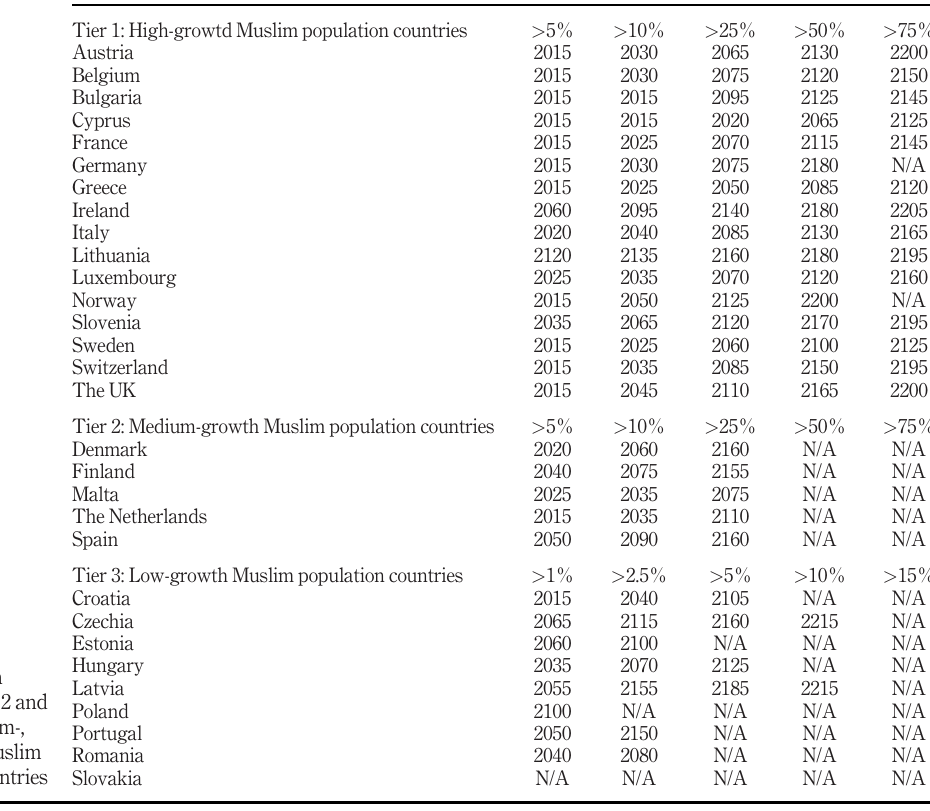
Table II. 2017 Migration scenario tier 1, 2 and 3, high-, medium-, low-growth Muslim population